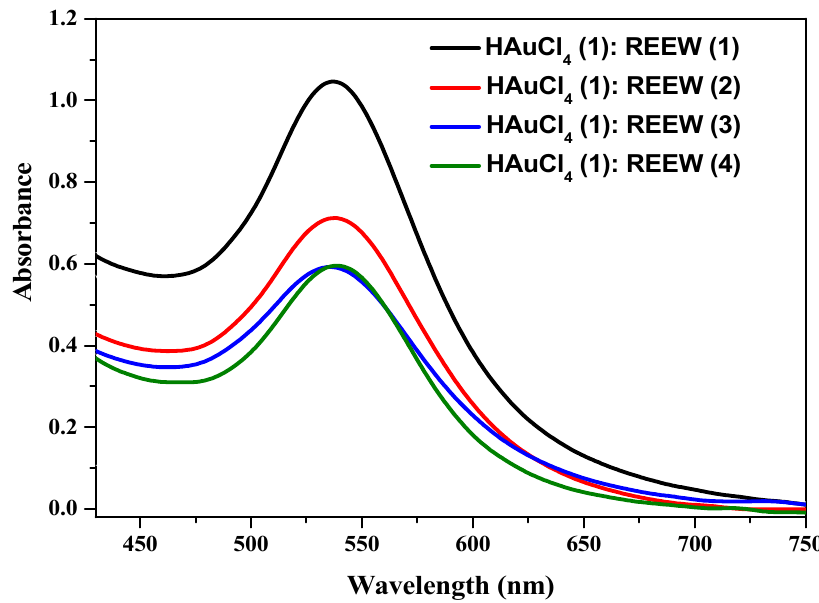
Figure 1. UV–visible absorption spectra of REEW-stabilized GNs suspension. The SEM image confirmed the formation of spherical and spheroidal GNs with a variable size, ranging from 20–130 nm with a mean of 115 ± 12 nm (Figure 2a). Owing to the high surface-to-volume ratio of GNs, some aggregation was observed, but the use of REEW’s extract seemed to stabilize the particles as individual spherical GNs were also observed in the SEM image. The presence of metallic gold in synthesized nanoparticles was confirmed by elemental analysis using energy-dispersive X-ray spectroscopy (EDS), which showed the characteristic X-ray emission peaks of Au (2.1 keV) in the EDS spectrum of the spherical particles observed in the SEM image (Figure 2b). The C and O signals were likely due to X-ray emission from carbohydrates/proteins present in plant extract [26]. The hydrodynamic size and surface charge of the colloidal REEW-GNs were analyzed using dynamic light scattering (DLS) and zeta potential measurements. The result of the zeta potential shown and DLS in Figure 2c,d, respectively, revealed a moderate to high polydispersity in size distribution with an average hydrodynamic size of 78 nm with a zeta potential of − 18.1